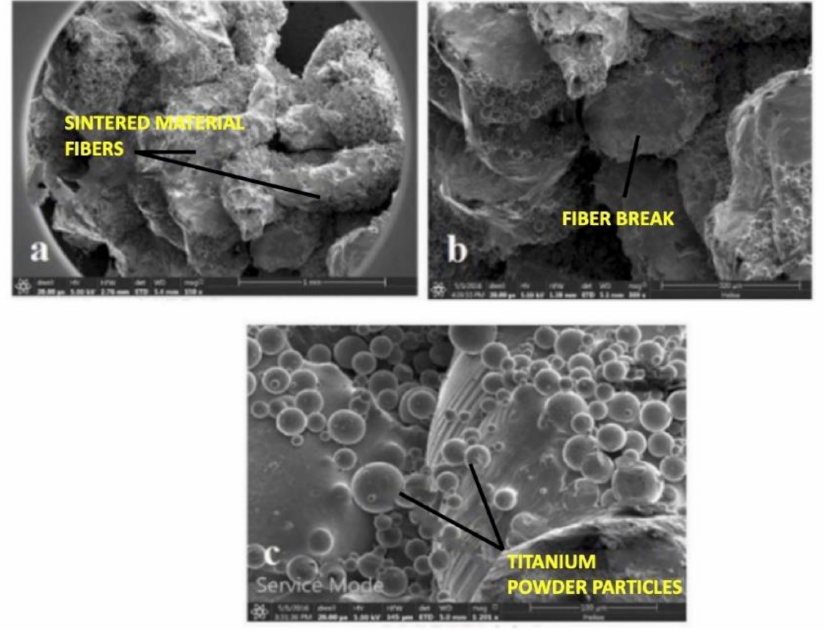
Figure 18. Microstructure of sample: ( a ) 1 mm ( b ) 100 µ m ( c ) 500 µ